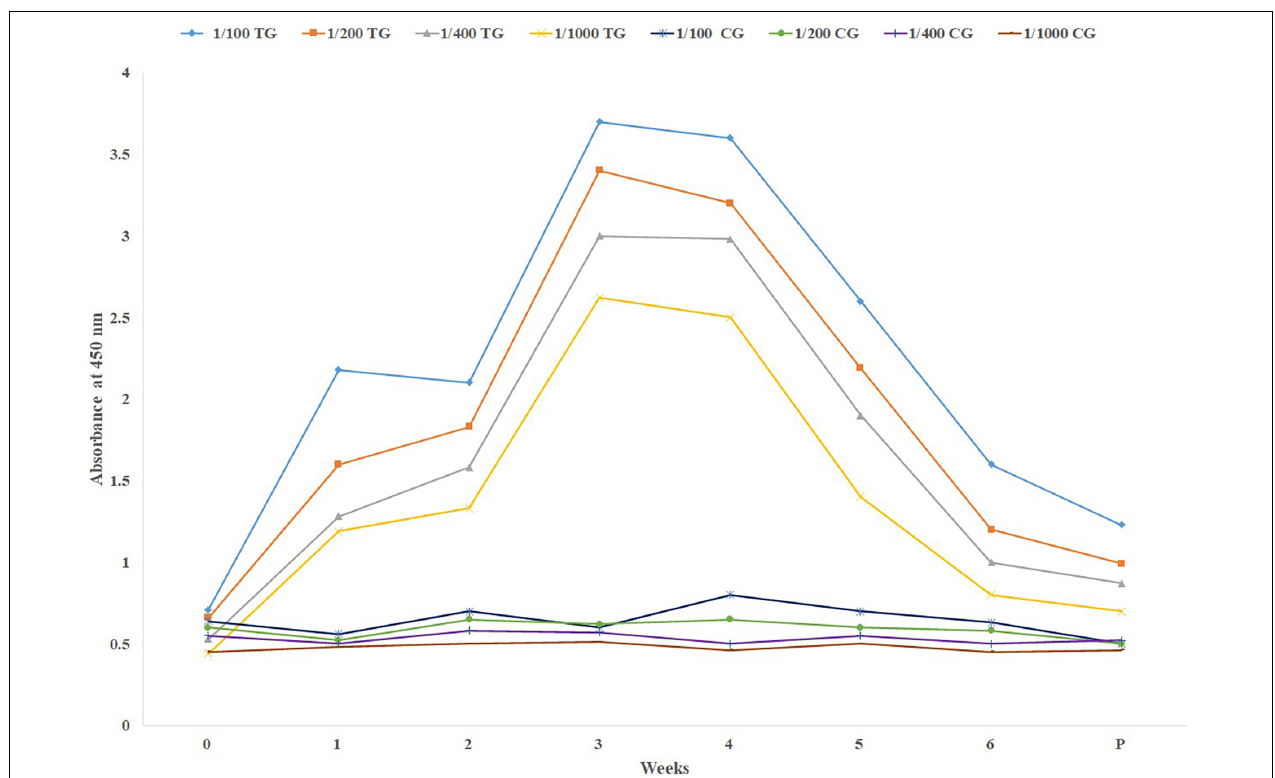
FIGURE 1 | Mean specific IgG level in different sera dilutions of six treatment and three negative control pregnant cows before parturition, using in-direct ELISA test. TG, Treatment group; CG, Control group; Week 0, First virus inoculation; Week 2, First booster; Week 4, Second booster; P,